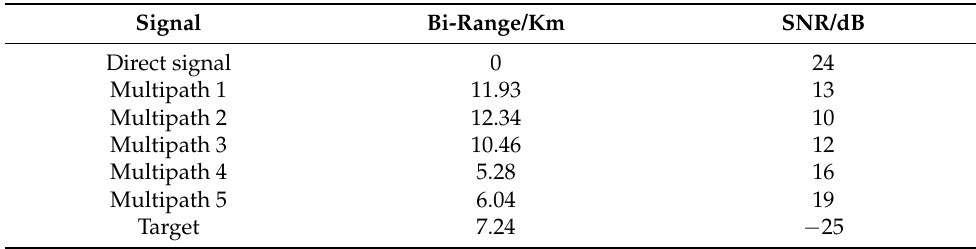
Table 2. The simulation parameters.